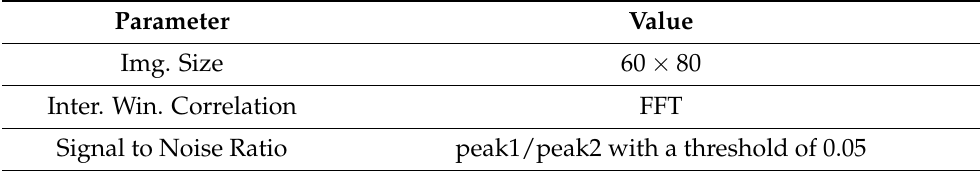
Table 2. PIV parameters used in absolute error comparison